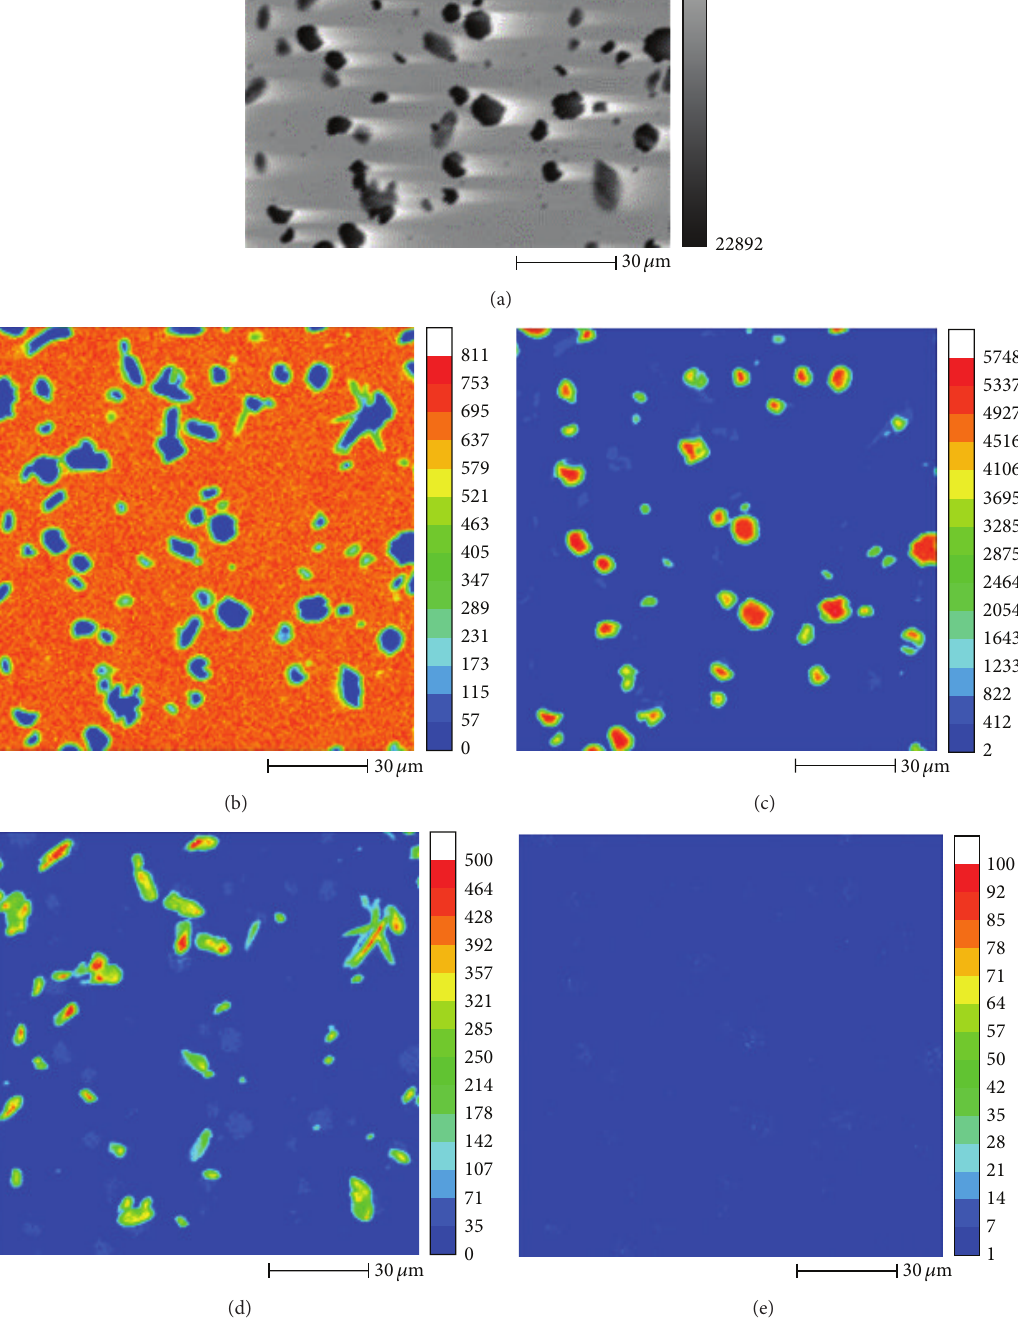
Figure 7: Elemental distribution analyzed by EPMA on the surface of DCI, which was passivated for 72 hours in tap water with 100k ppm TEA addition at 25 ∘ C. (a) SEM image, (b) Fe, (c) C, (d) O, and (e)